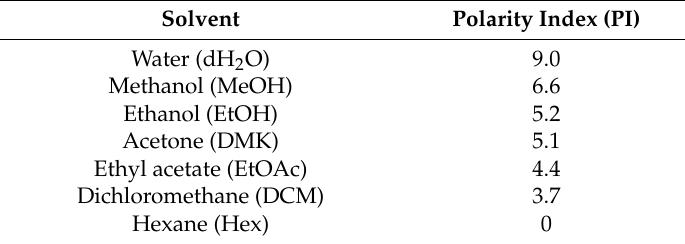
Table 1. Polarity index (Snyder [27]).